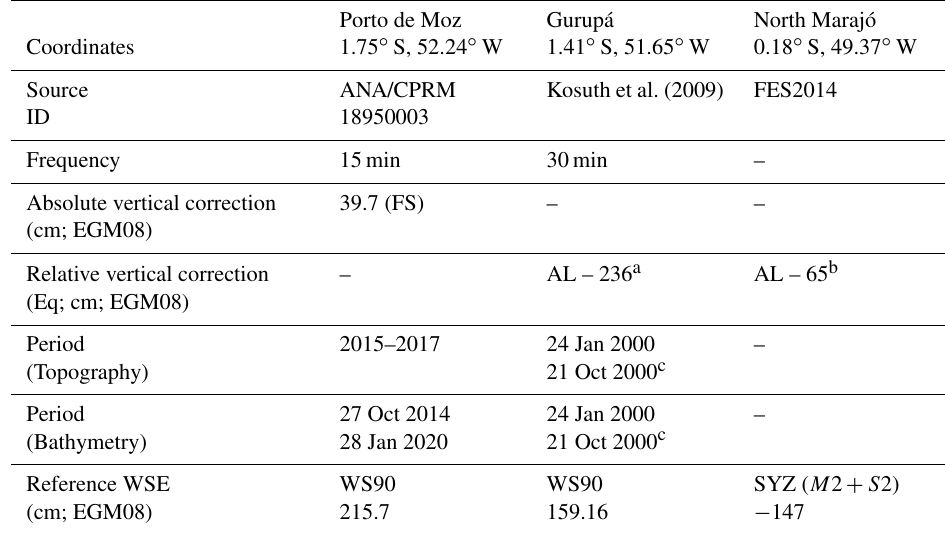
Table A3. Gauge station in the South Channel of the Amazon estuary.